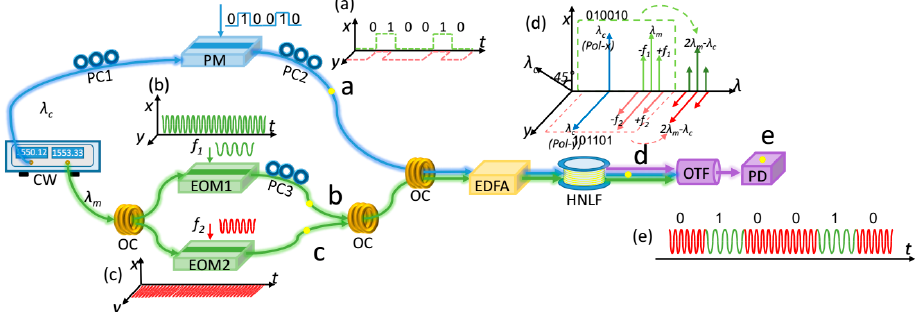
Figure 12. Experimental setup and operation principle of real-time RF switching for frequency hopping system using optical four wave mixing. CW: continuous wavelength laser source; EOM: electro optical modulator; EDFA: Erbium-doped fiber amplifier; HNLF: highly nonlinear fiber; OTF: optical tunable filter; PD: photodetector. ( a ) hopping code sequence; ( b ) and ( c ) modulated RF signals on the same wavelength but different polarization;( d ) FWM results after HNLF; ( e ) resultant frequency-hopping signals.